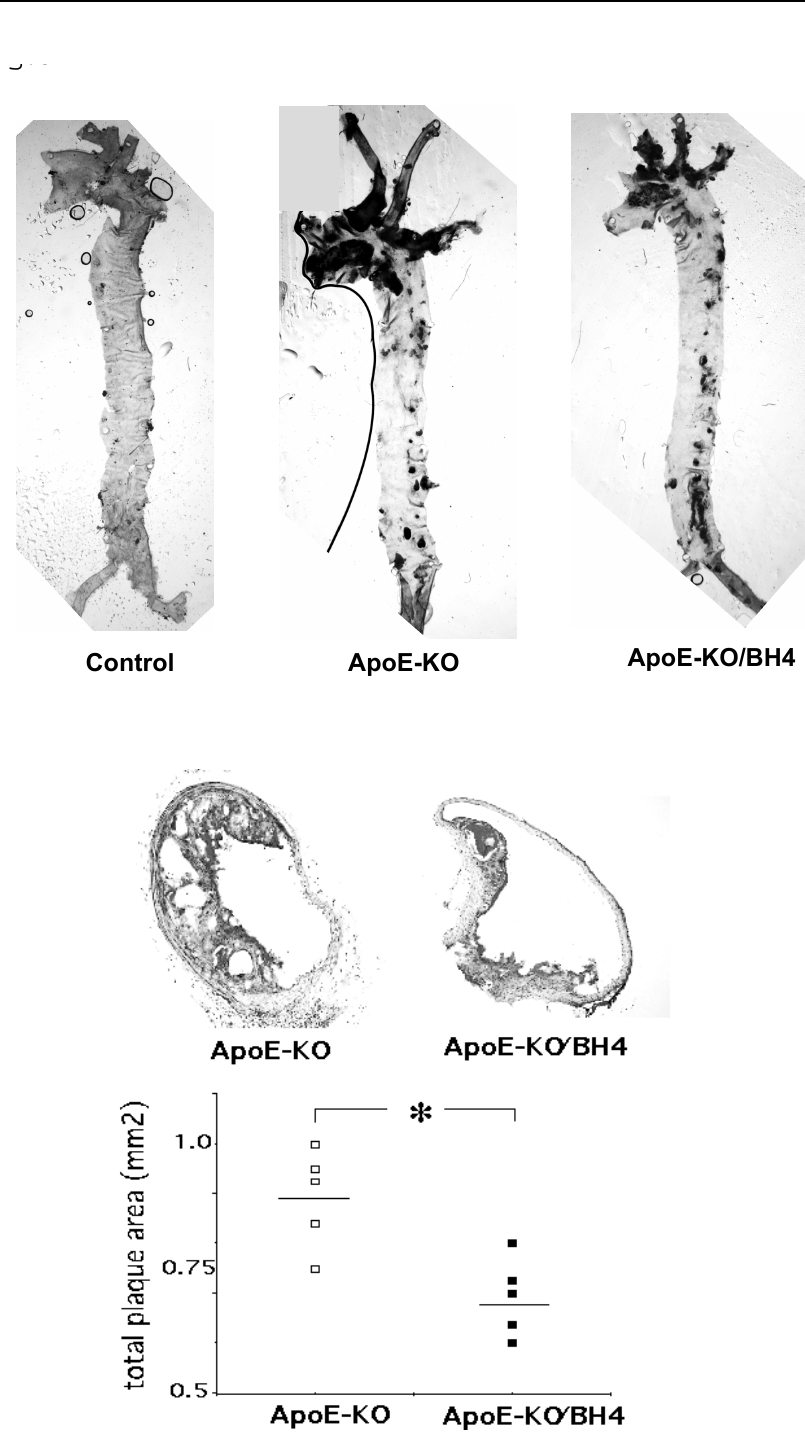
Figure 3. (A) Atherosclerotic lesions in aortas stained with oil red O solution, longitudinally opened aortas from control, apoE-KO, and apoE-KO/BH mice. Lipid stained area in the aortic sinus of apoE-KO and apoE-KO/BH 4 mice was 41.2 ± 1.4 vs 52.3 ± 2.6 % (n = 5; *P < 0.05). (B) Aortic root plaque area in ApoE-KO (white squares) and ApoE-KO/BH mice (black squares), with representative aortic root sections (5x objective) from each group, 4 stained stained with oil red O solution. Mean plaque area (indicated by horizontal black lines) was 25% lower in ApoE-KO/BH mice (0.66 mm 2 ) compared with ApoE-KO mice (0.88 mm 2 ) (n = 5 animals per group; *P < 0.05). 4 Black bars on photomicrographs represent 200 µ